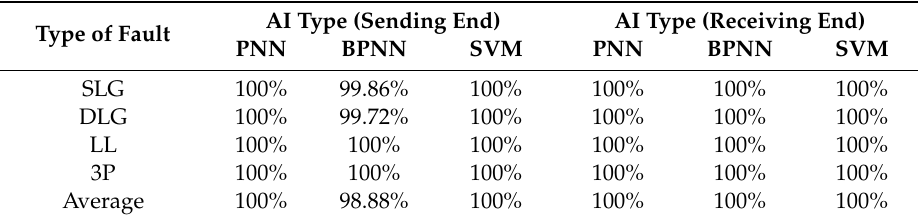
Table 2. Percentage of accurate results.